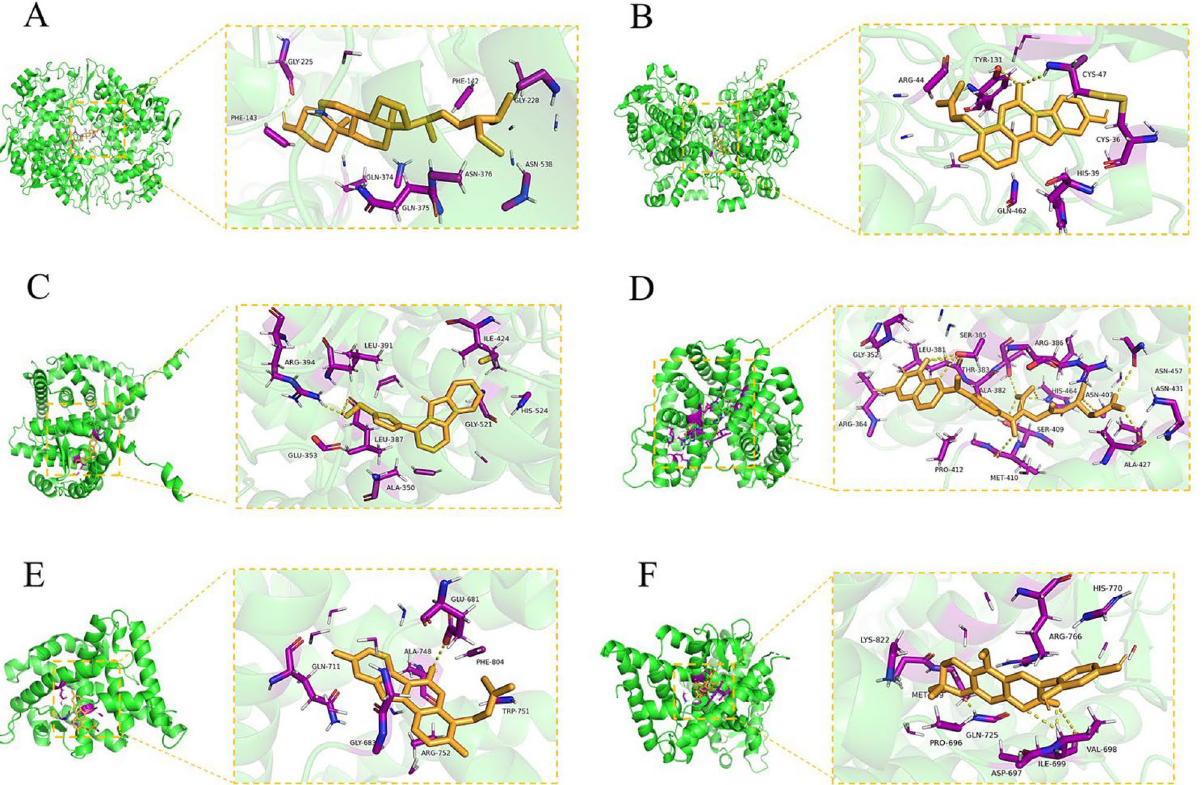
Figure 7. Schematic 3D representation of molecular docking models, active sites, and binding distances. Binding modes of: stigmasterol to PTGS2 (PDB id:5ikq) ( A ), phaseol to PTGS2 ( B ), perlolyrine to ESR1 (PDB id: 1a52) ( C ), DIOP to ESR2 (PDB id: 3ols) ( D ), phaseol to AR (PDB id:1e3g) ( E ), and licopyranocoumarin to PGR(PDB id: 3g8o) ( F